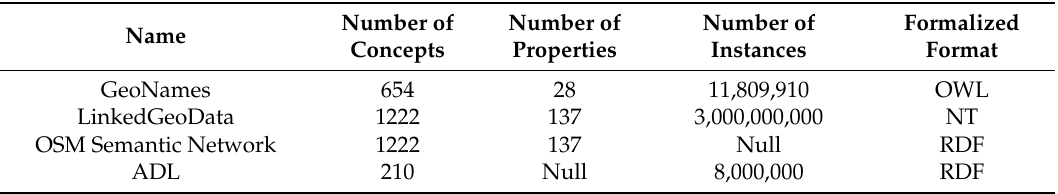
Table 1. The numbers of concepts, properties, and instances in some geographic semantic webs (obtained on 18 January